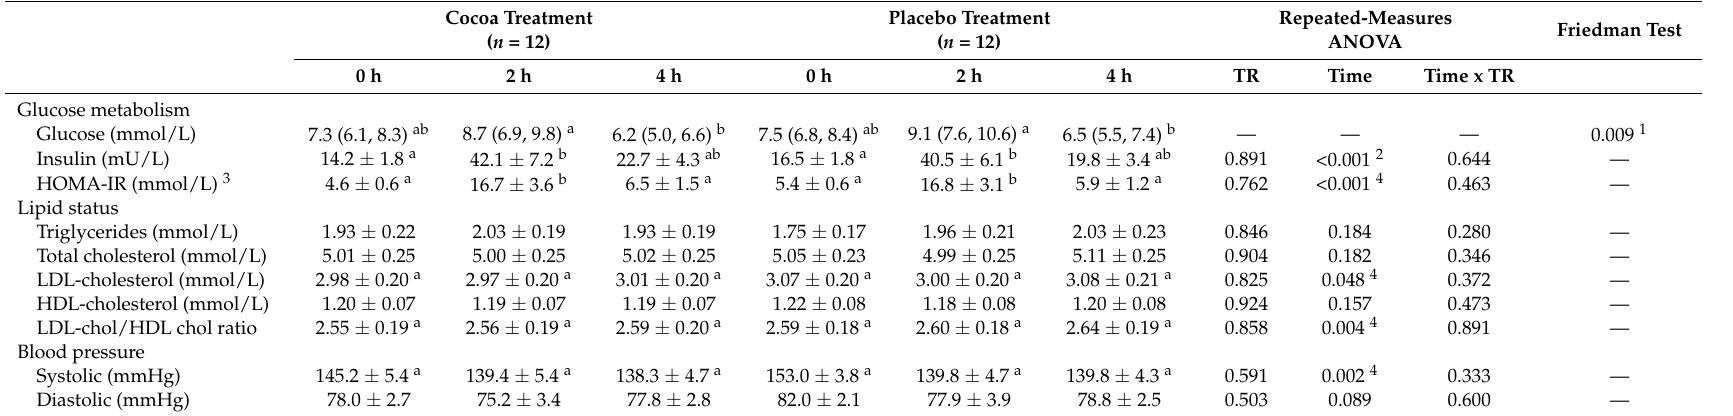
Table 5. Results on glucose and lipid metabolism and on blood